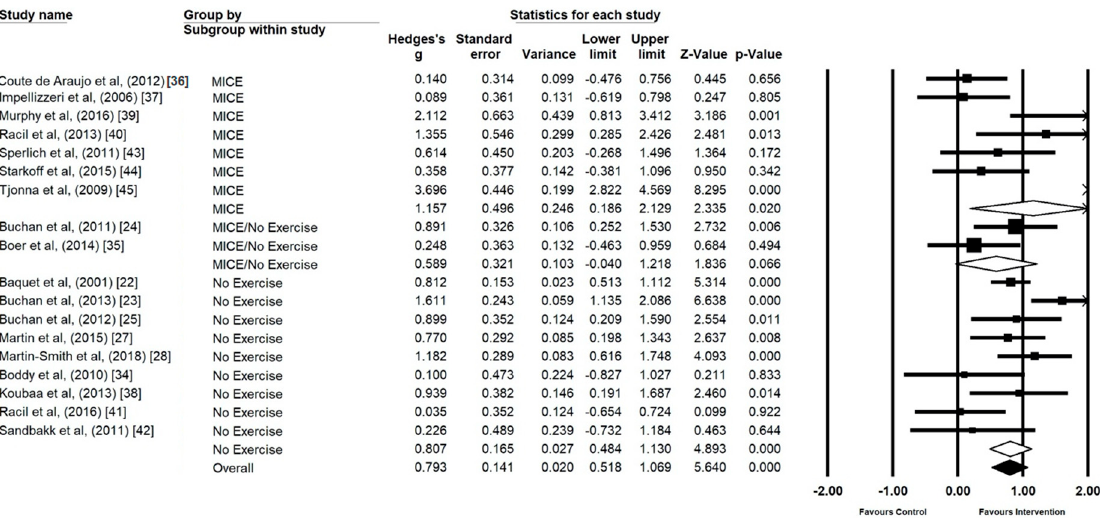
Figure 7. Forest Plot of control group type, individual and group analysis.